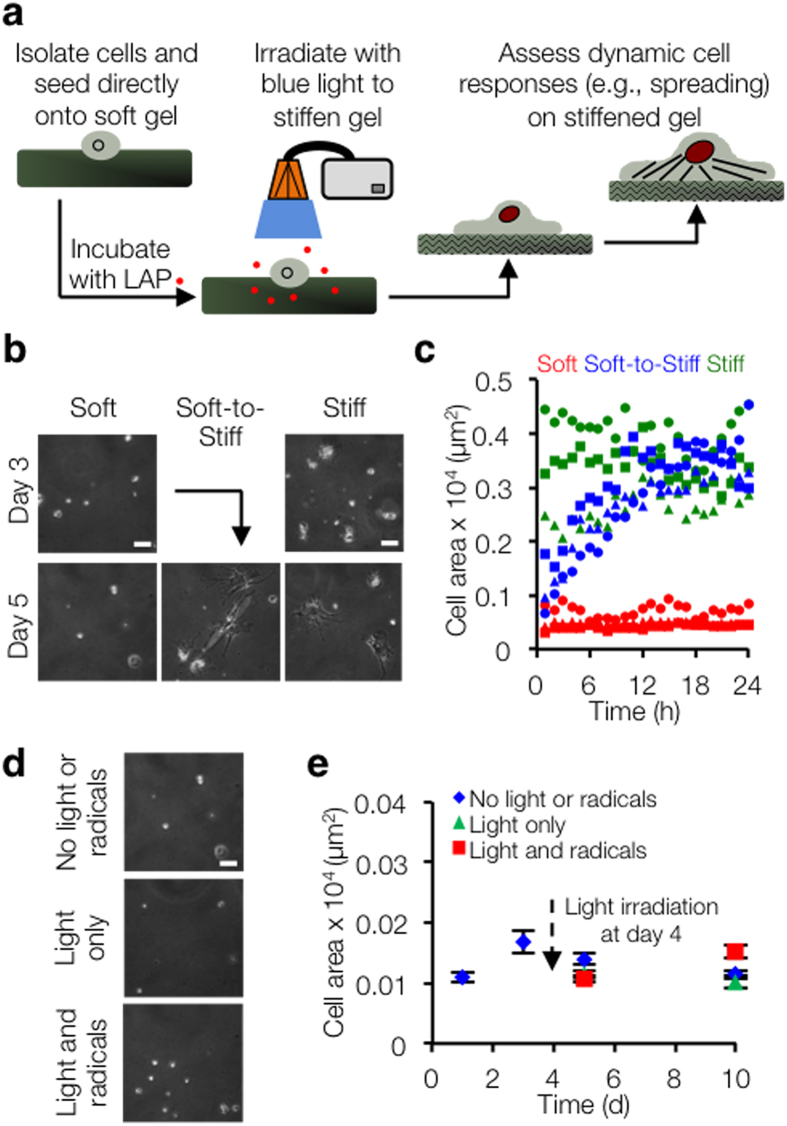
Hepatic stellate cells spread and assume myofibroblast morphology in response to in situ stiffening.(a) Schematic of in situ stiffening process. (b) Phase contrast images of stellate cells on soft and stiff static substrates, as well as a dynamically stiffened soft-to-stiff substrate (in situ stiffening performed on day 4). Scale bars: 50 μm. (c) Representative stellate cell spread area quantification over 24 h time lapse following in situ stiffening on day 4 (n = 3 cells per group, each shape represents a single cell whose spread area was monitored every 15 min). Spread areas are relatively constant in soft and stiff static groups, but increase steadily in soft-to-stiff group, especially during the first 12 h. (d) To ensure that stellate cells were spreading in response to stiffness and not free radical generation, soft MeHA gels were fabricated where the remaining methacrylates were capped with a thiol, so that in the presence of light and initiator free radicals would be generated but no secondary crosslinking (stiffening) would occur. Representative phase contrast images showed no differences in cell spread areas between groups. Scale bars: 50 μm. (e) Quantification of cell area confirmed no differences in spread area between groups (n > 22 cells per group per time point, error bars represent s.e.m.).